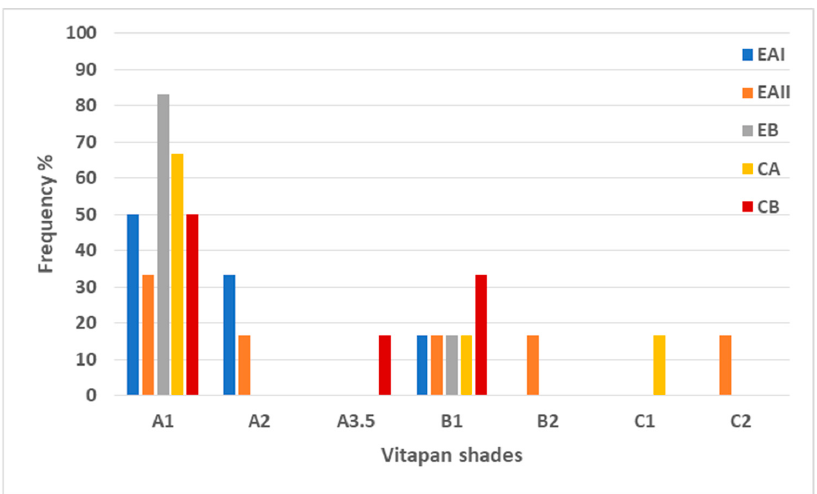
Figure 3. Frequency% of the Vitapan shades across the groups . All the tooth samples treated